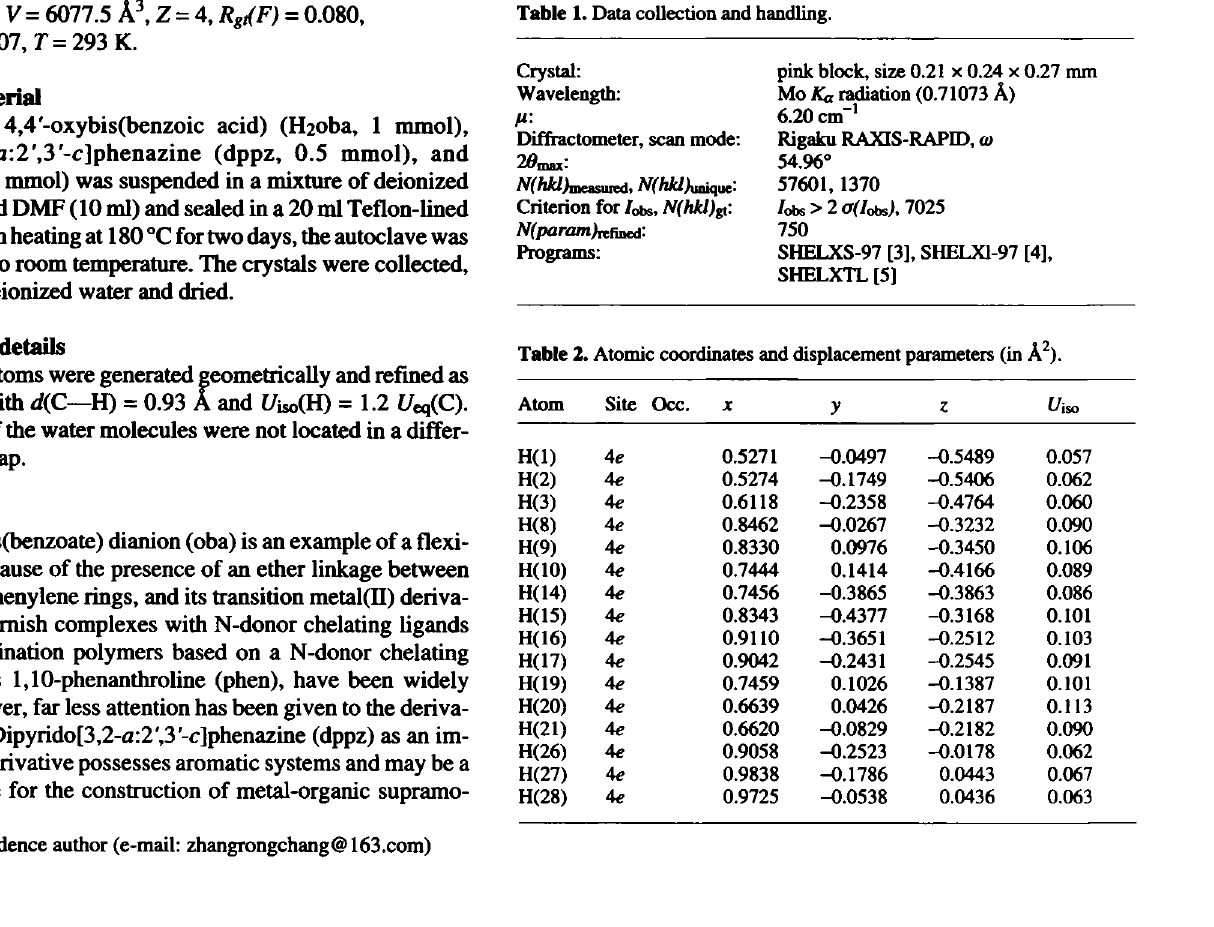
Table 2. Atomic coordinates and displacement parameters (in Â 2